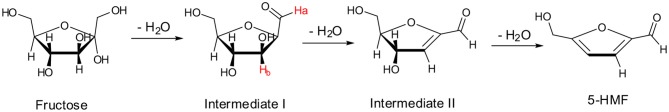
Intermediates hypothesized for the dehydration of fructose into 5-HMF.